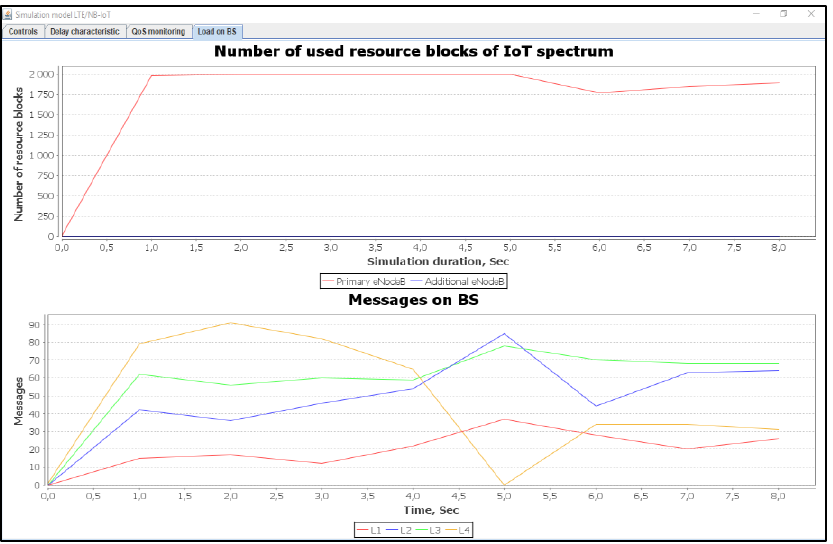
Figure 21. Used IoT spectrum resource blocks and transmitted messages ratio for different priorities (average load of IoT controller ρ = 75%).